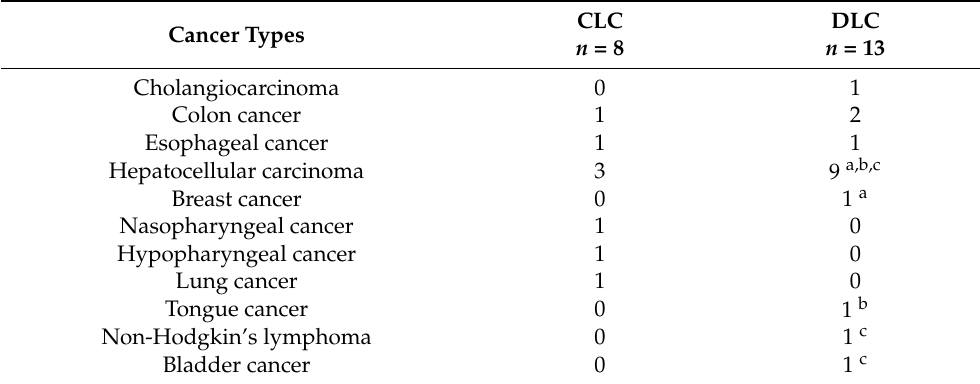
Table 4. Malignancy types between the compensated liver cirrhosis group and the decompensated liver cirrhosis